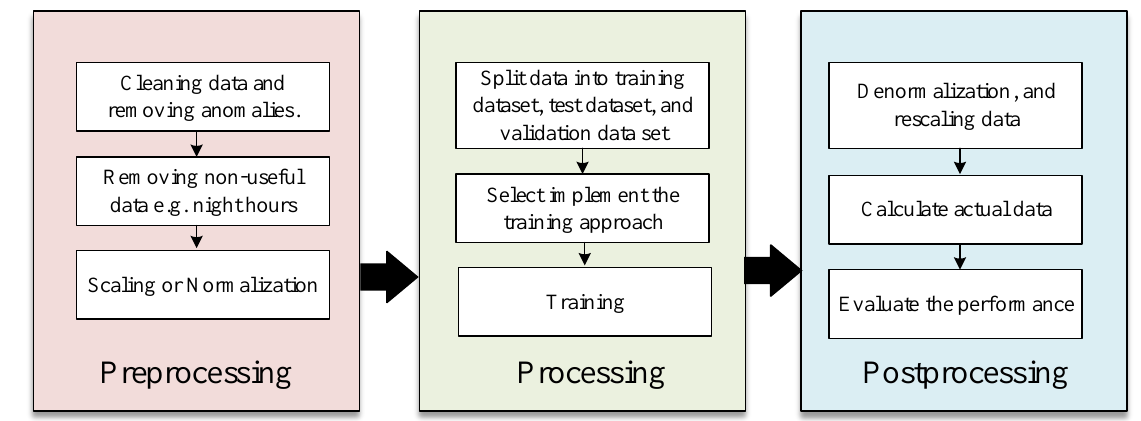
Figure 8. The prediction methodology, which consists of three